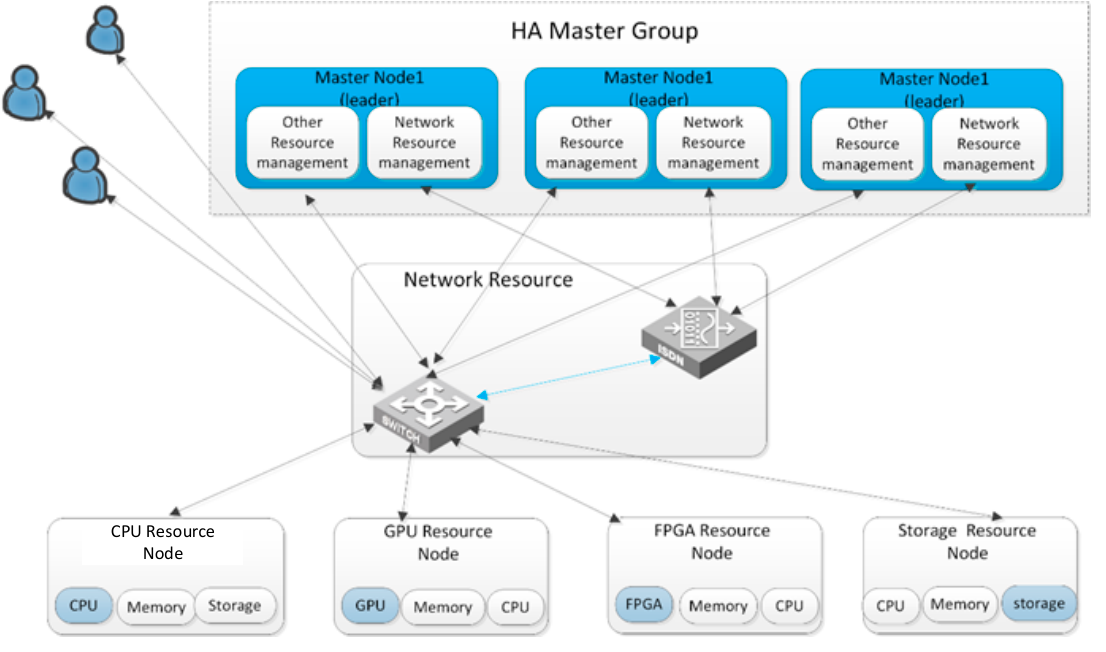
Figure 2. The framework of the resource platform.